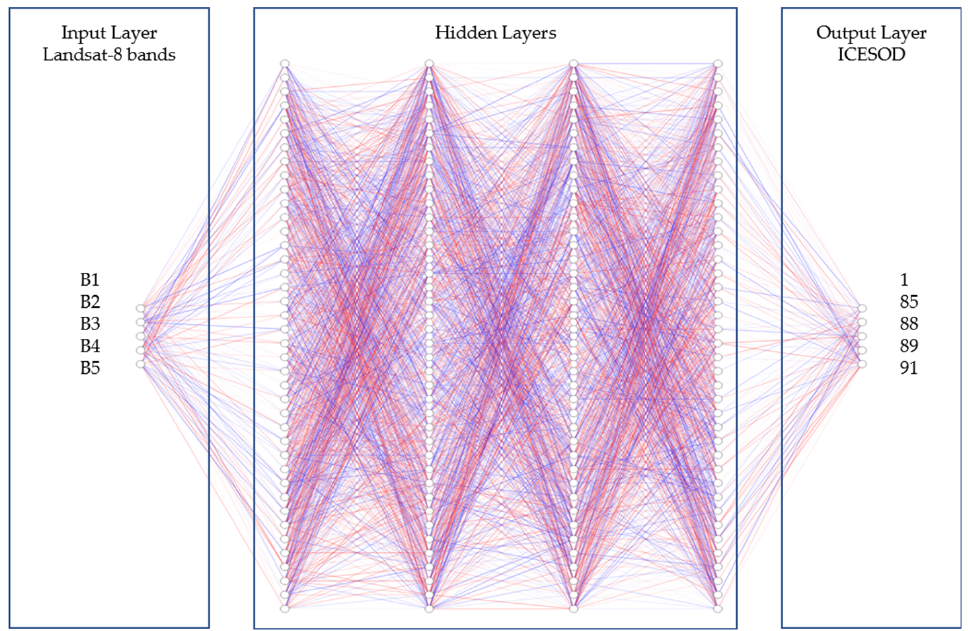
Figure 6. DNN architecture. The input layer has 5 nodes corresponding to the Landsat-8 top of atmosphere values, the output layer has 5 nodes corresponding to the ICESOD codes. The 4 hidden layers have 40 nodes each.